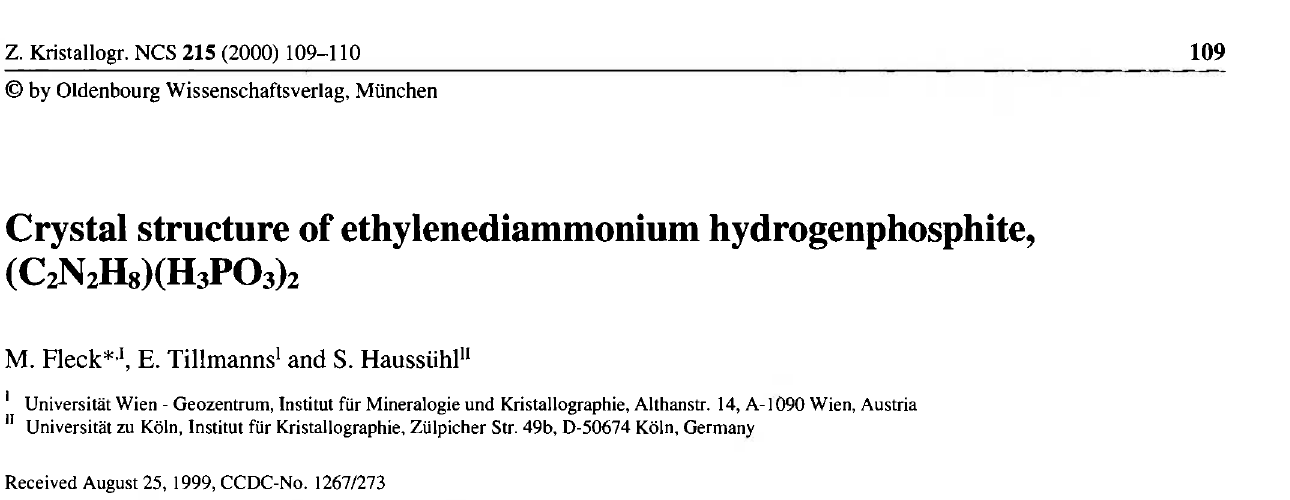
Table 1. Data collection and handling.